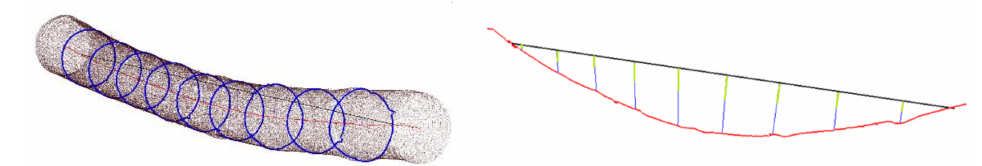
Figure 4. Visualization of the segment method of a pine of the length of 5.08 m. For nine segments (blue circles), a bow height (blue) is calculated as the shortest distance between a reference line (black) and a center line (red) and afterwards reduced by the diameter-dependent permissible curvature (green).